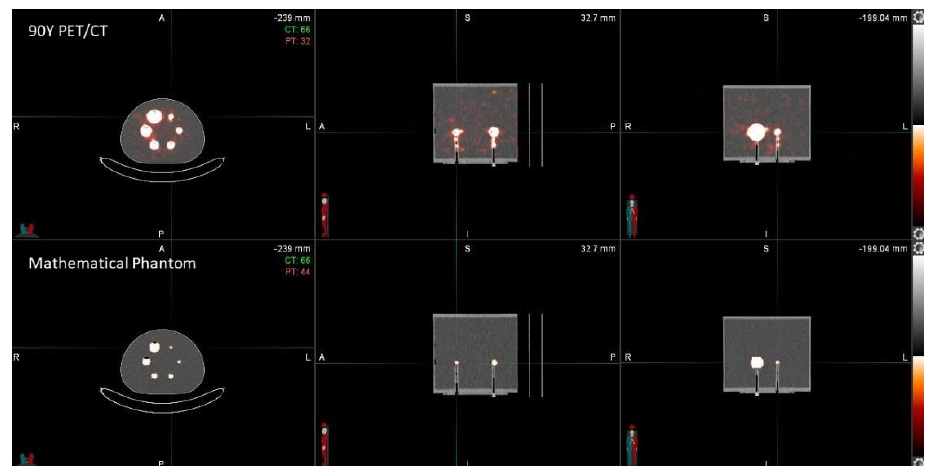
Figure 3. Experimental 90Y  PET/CT and mathematical uniform IEC NEMA Torso phantoms.